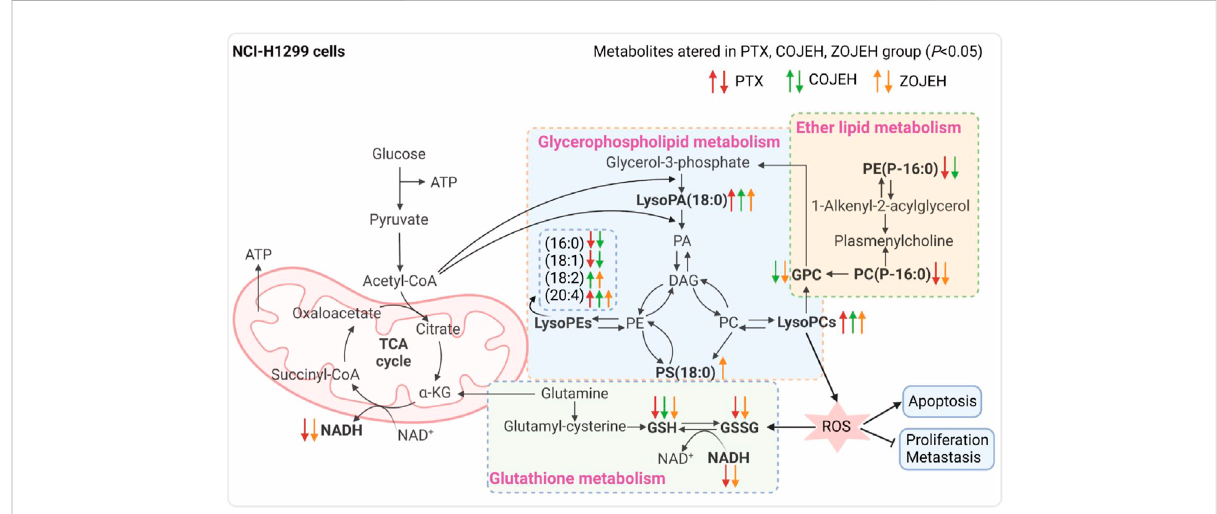
FIGURE 8 Signi fi cantly altered metabolic pathways. Metabolites in bold are metabolites disturbed by PTX, COJEH and/or ZOJEH group. Red, green and orange arrows represent up-regulation/down-regulation by PTX, COJEH and ZOJH group, respectively, when compared with that in control group. (PA, phosphatidic acid; DAG, diacylglycerol; PC, phosphatidylcholine; PE, phosphatidylethanolamine; PS, phosphatidylserine; GPC, glycerophosphocholine; α -KG, alpha ketoglutarate; GSH, glutathione; GSSG, oxidized glutathione; ROS, reactive oxygen species.) The image was created with